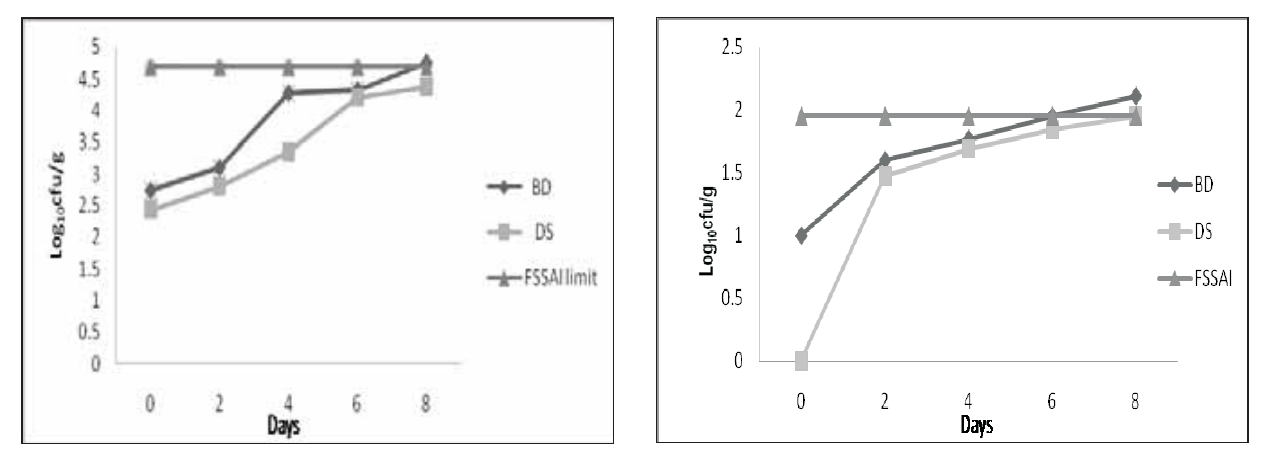
Figure-2: SPC in low cholesterol masala paneer products Figure-3: Coliform counts in low cholesterol masala paneer products